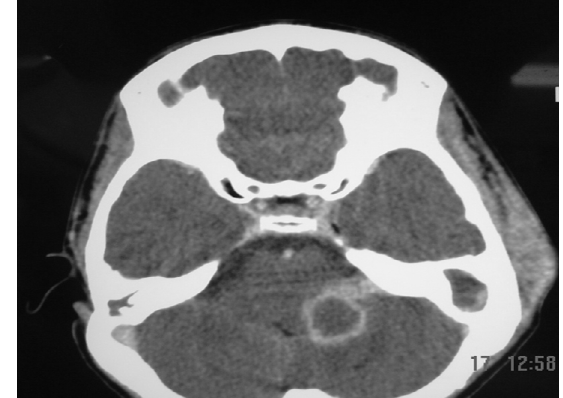
Figure 2 Brain CT with contrast, axial view and soft tissue window. It shows a cerebellar abscess on the left. Note : soft tissue edema, adjacent to the left temporal bone, consistent with mastoiditis.